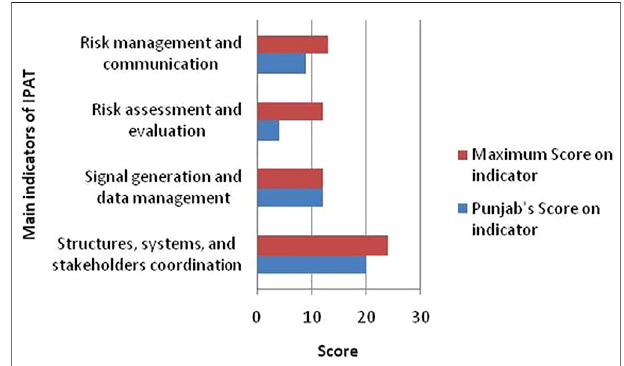
FIGURE 3 | Score of Punjab PV center on main indicators of